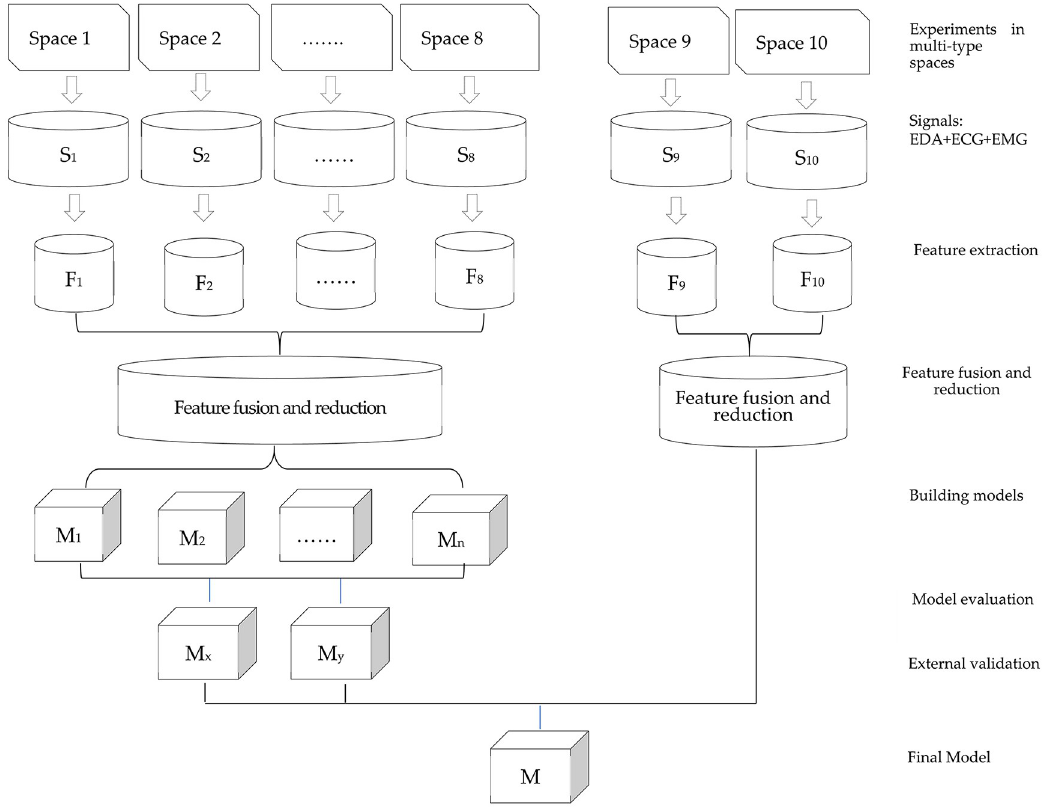
Fig 1. Flowchart of the experiment and data analysis